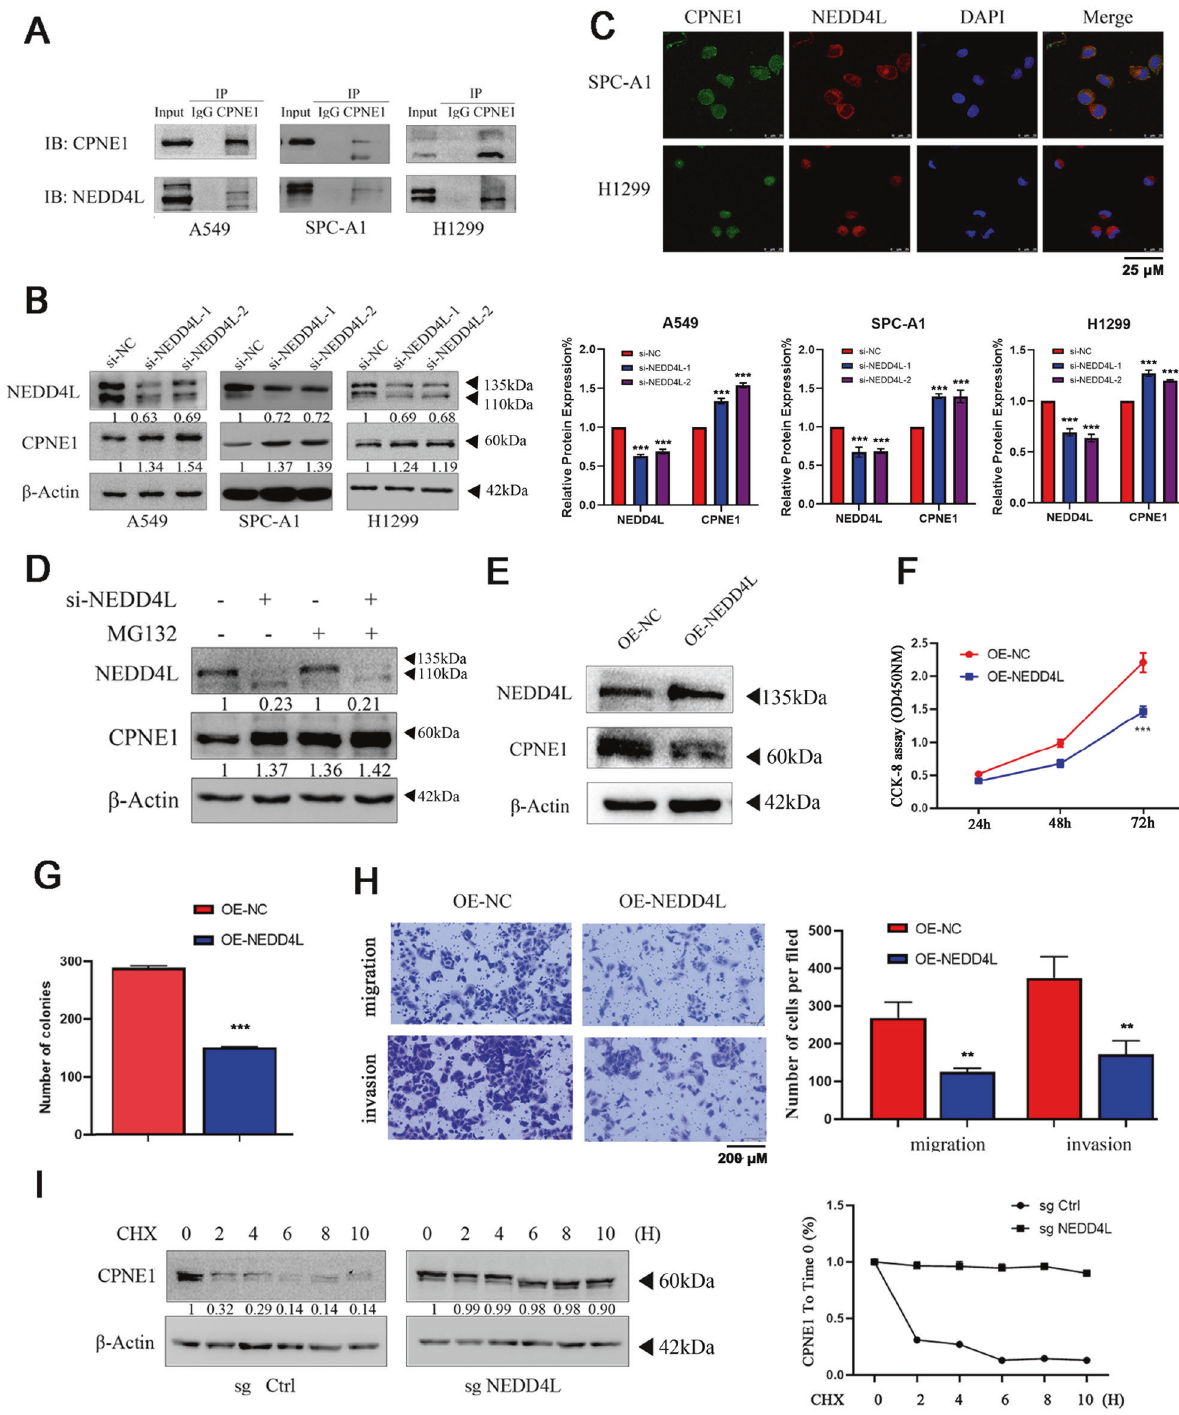
Fig. 5 NEDD4L interacts with the CPNE1 protein. A The co-immunoprecipitation assay proved the association between endogenous CPNE1 and NEDD4L. Co-immunoprecipitation was performed as indicated. B CPNE1 protein levels in si-NEDD4L NSCLC cells. C Immuno fl uorescence was used to detect the intracellular localization of CPNE1 and NEDD4L. The intracellular localization of CPNE1 (green) and NEDD4L(red) is shown. D Upregulation of CPNE induced by NEDD4L interference was reduced by MG132 treatment. A549 cells were transfected with si-NEDD4L or si-Control. MG132 was added 6 h prior to protein extraction. E NEDD4L protein levels in NEDD4L overexpression A549 cells. F CCK-8 assay of cell viability in A549 (OE-NEDD4L compared with OE-NC). G the results of clonogenic analysis of cell proliferation in A549 cells (OE-NEDD4L compared with OE-NC). H Representative images of the transwell assay results for cell migration and invasion in A549 cells (OE-NEDD4L compared with OE-NC). I NEDD4L decreases CPNE1 half-life in HEK 293 T cells. Cells were transfected with sg-Control and sg- NEDD4L. 100 μ g/ml cycloheximide was added for indicated times prior to protein extraction. Image J was used to quantify the CPNE1 protein level. ** P < 0.01; *** P <